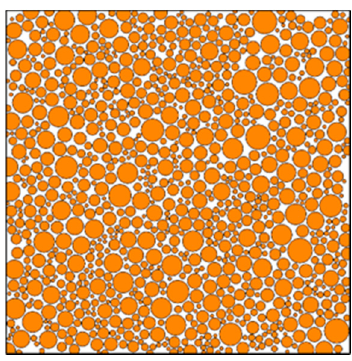
Figure 2. Microparticle filling model of HTPB composite solid propellant.